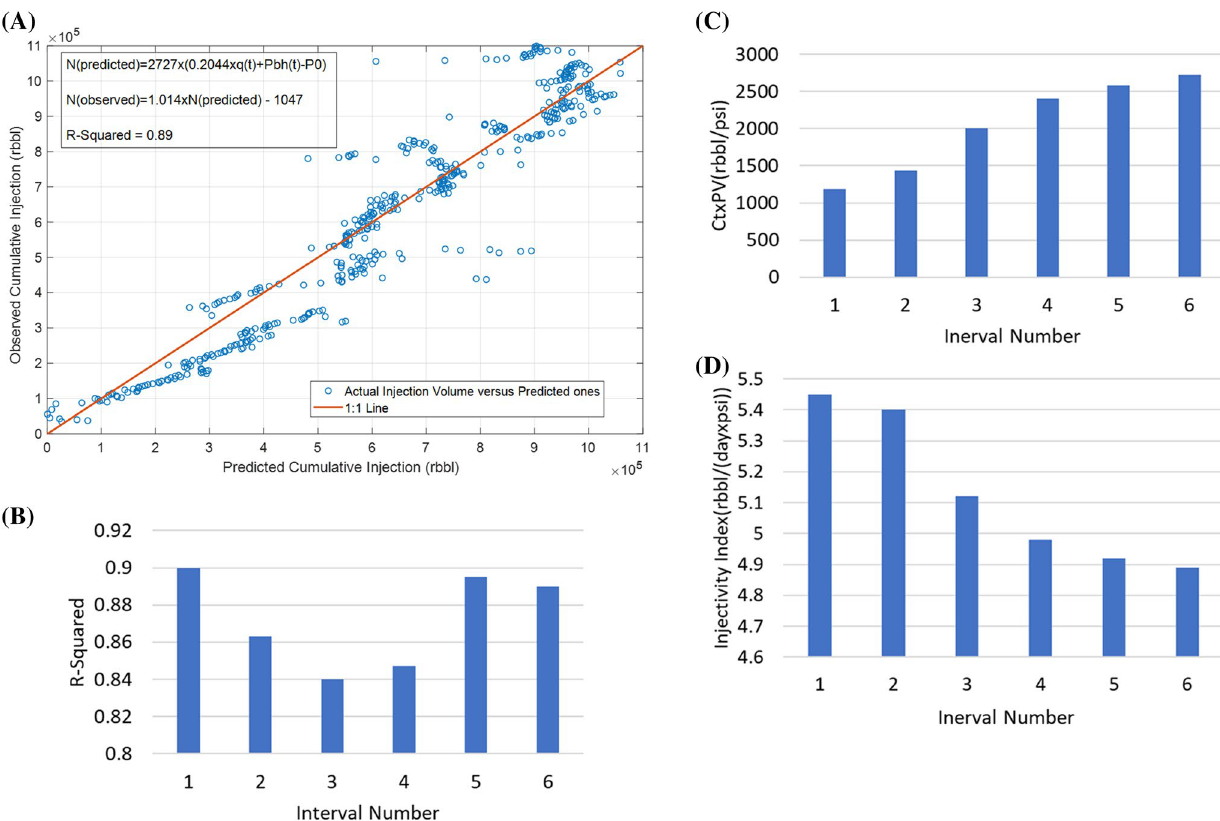
Fig. 7 a Actual (field) CO 2 injection volume versus fitted data using simplified physics-based model for middle lobe and the 1:1 line for predicted versus actual data. b Estimation of R-squared in different time intervals